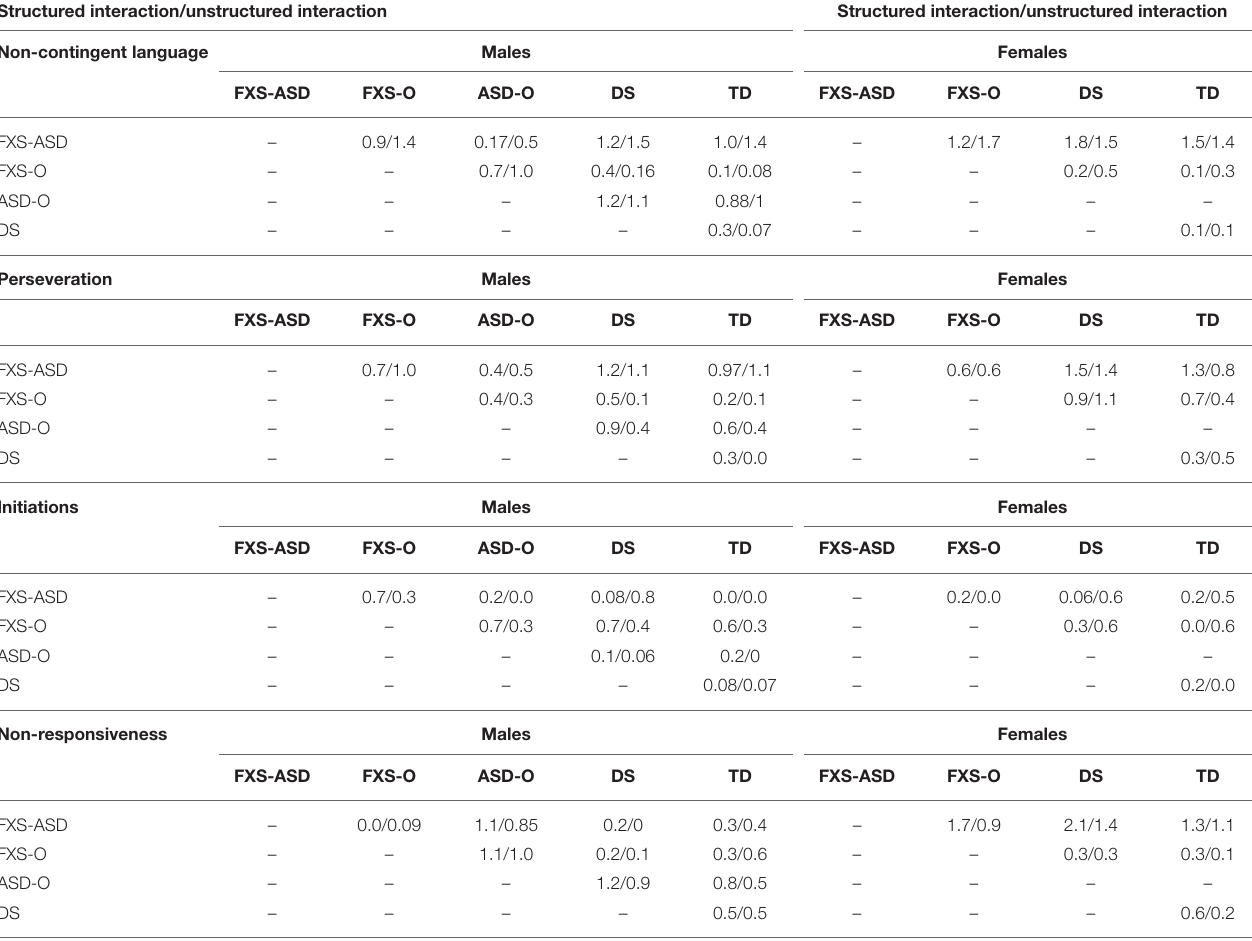
TABLE 3.3 | Effect sizes (Cohen’s d) for pragmatic language in males and females.